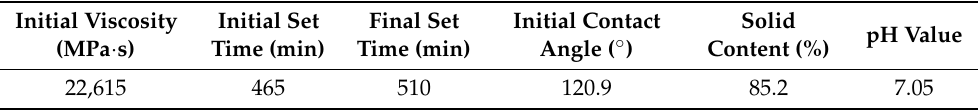
Table 4. Parameters of MOPB-FA (M = 5, H = 15, FA addition = 20 wt%). Initial Viscosity